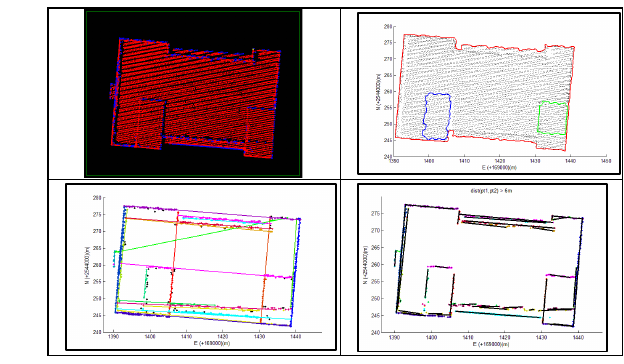
Figure 18. Test results of building 6.